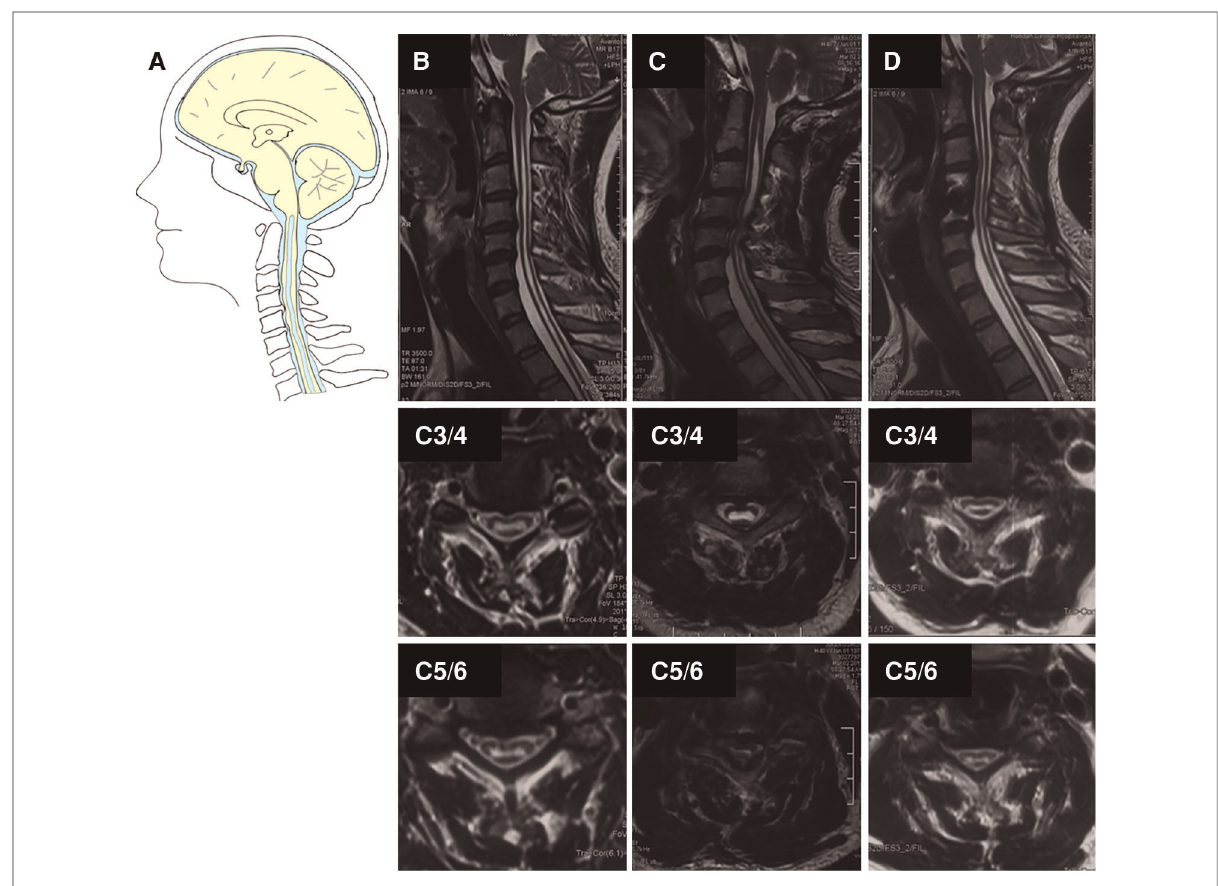
FIGURE 4 Case presentation of cervical disc herniation in Group III, ( A ) schematic drawings of the foramen magnum, sagittal view. Sagittal (upper), axial (middle, C3/4), and axial (down, C5/6) . ( B ) Preoperative MRI showed the Chiari I malformation and syrinx. ( C ) Postoperative MRI after 4 years showed obvious C4/5-disc herniation and enlarged cervical syrinx above C4/5 level (red arrow). ( D ) A postoperative MRI after ACDF showed the cervical spinal canal was completely decompressed and the syrinx above C4/5 was partially resolved and lower extremity in fl exibility